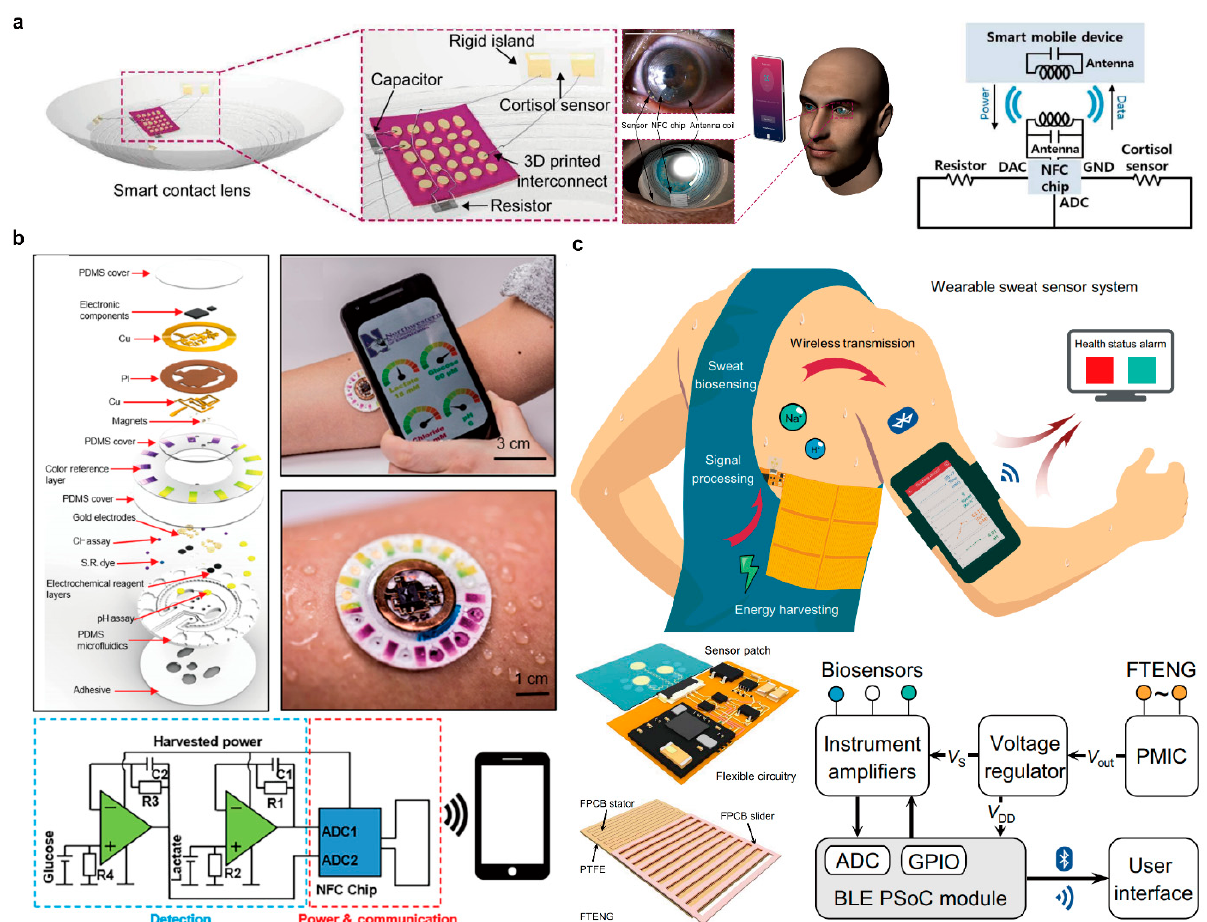
Figure 7. ( a ) Smart contact lens for wireless cortisol monitoring integrated with a cortisol sensor, antennas, and wireless communication circuits operated via NFC (reprinted with permission from [14]. Copyright 2020 American Association for the Advancement of Science); ( b ) Wireless skin-interfaced sensor integrated with a microfluidic module, colorimetry sensor, biofuel cell-based electrochemical sensor, battery-free NFC electronics (reprinted with permission from [16]. Copyright 2019 American Association for the Advancement of Science); ( c ) Wireless wearable sweat sensor powered by human motion, equipped with a freestanding triboelectric nanogenerator (reprinted with permission from [160]. Copyright 2020 American Association for the Advancement of Science).